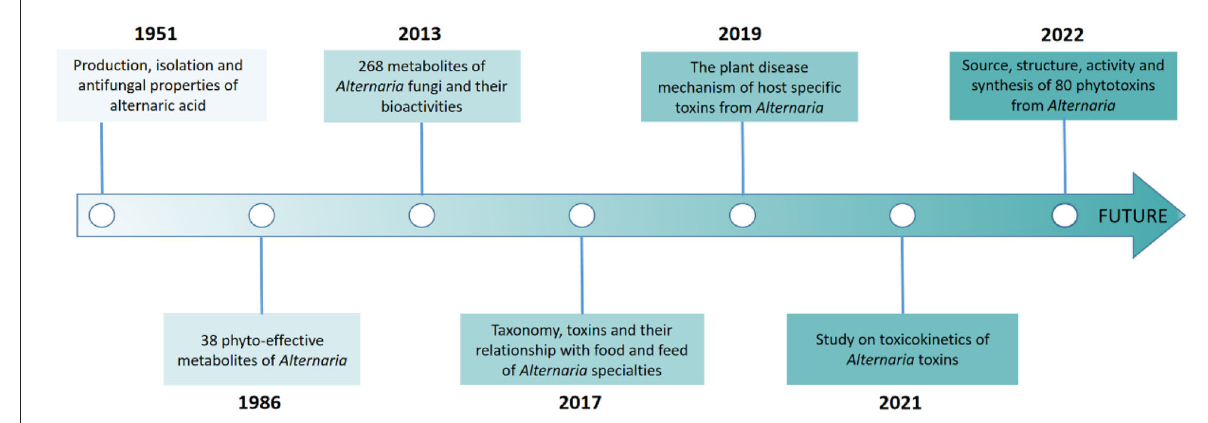
FIGURE1 Timeline of related studies on the bio-metabolites of Alternaria fungi.